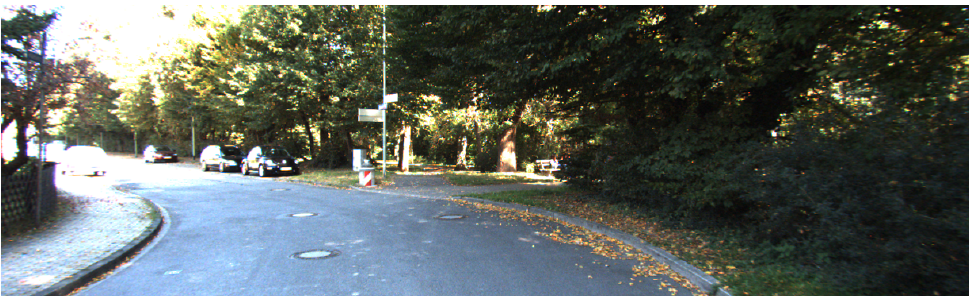
Figure 9. A critical section for our proposal: the vehicle is surrounded by trees and hedges.